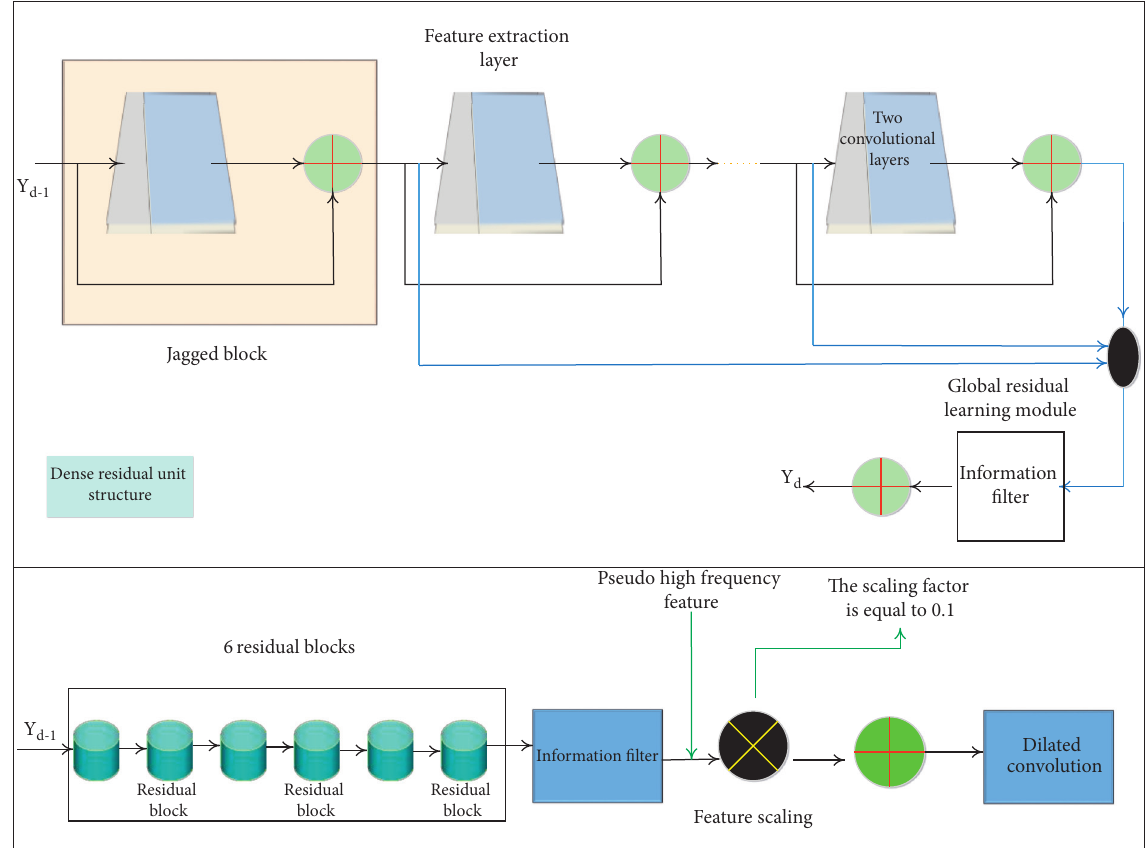
Figure 3: Residual relearning based on dense residual